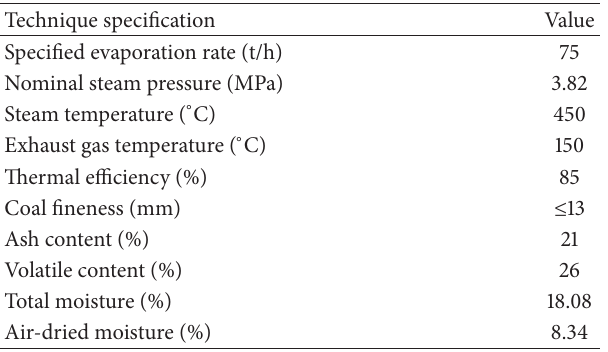
Table 1: Main technique specification of the CFB and industrial analysis data of coal of experiment I.